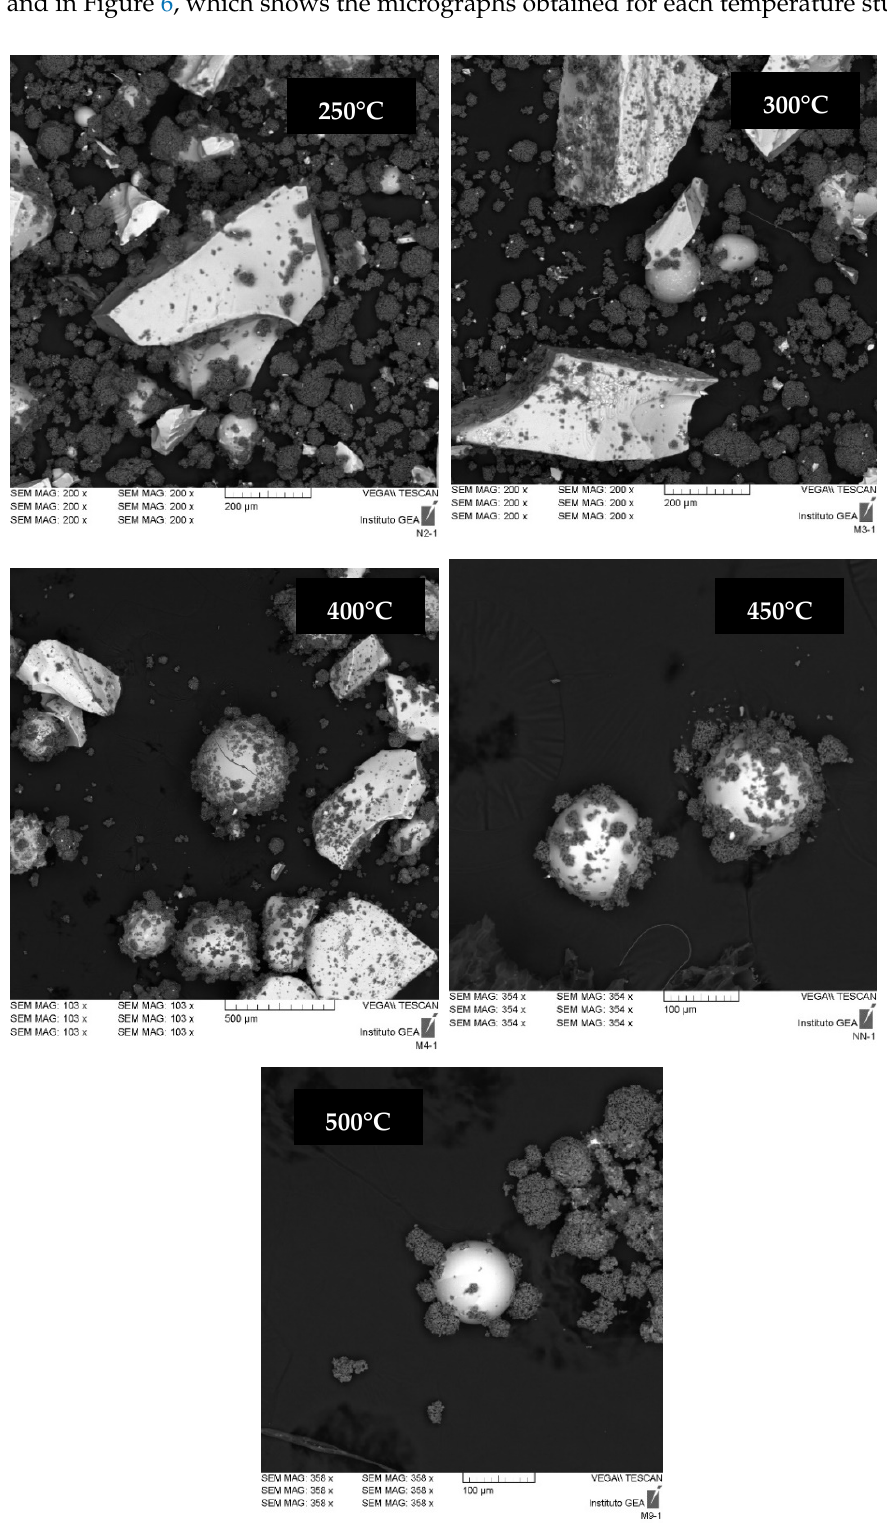
Figure 6. Micrographs obtained for each temperature studied by SEM-EDS analysis [own elabora- tion].